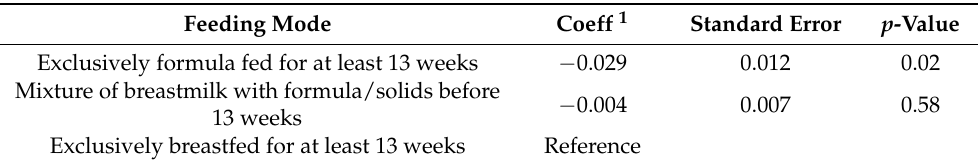
Table 3. Association of infant feeding modes and overall changes in DNA methylation based on 292,366 CpGs from birth to 10 years.